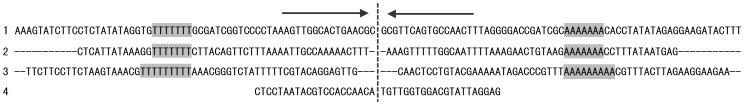
The comparison of sequences of stem-loop and hairpin structure from different mt genomes.
1: Gracilariopsis lemaneiformis (126 bp). 2: Plocamiocolax pulvinata (102 bp). 3: Chondrus crispus (116 bp). 4: the hairpin structure of Gr. lemaneiformis (42 bp). The dotted line indicates the middle point from where both sides are complete inverted repeat sequences. The shadow indicates polymers of A and T (n = 6, 8).